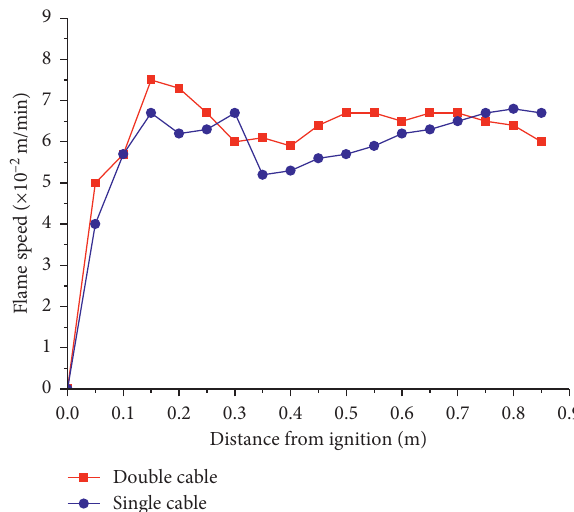
Figure 6: Flame spread curve of different cable with a fan frequency of